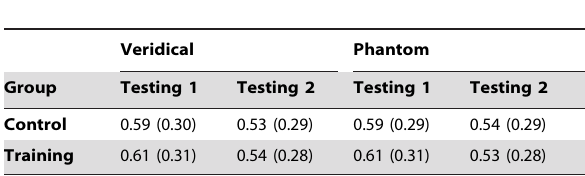
Table 2. The mean and SD (in parentheses) of response times (s) for veridical and phantom trials over the 1 st and 2 nd testing sessions split over the